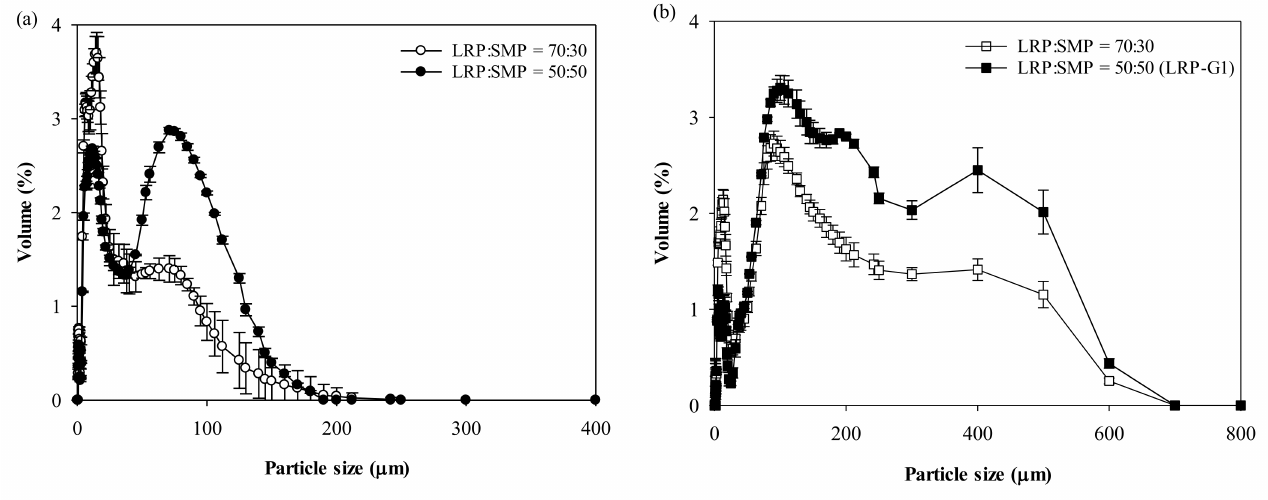
Figure 2. Particle size distribution of ( a ) LRP-SMP mixtures and ( b ) their granules obtained by fluidized-bed granulation. The granules obtained from the LRP-SMP mixture (50:50) were denoted as